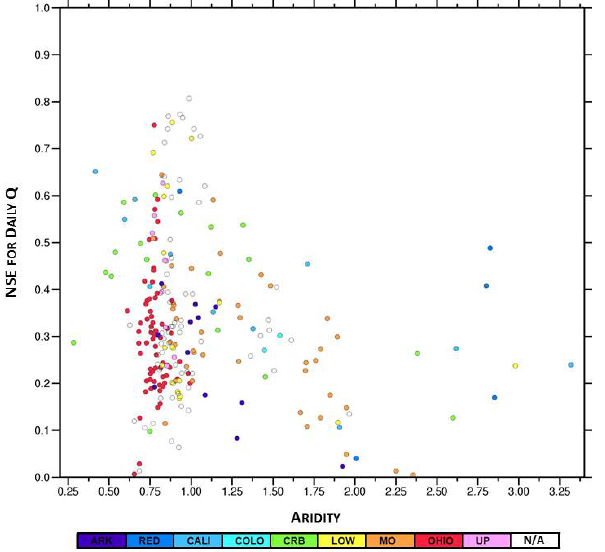
Fig. 10. NSE values for ULM calibrations towards ET SAT at a daily time step as a function of AI for the period 2001–2010. Shading of individual points denotes the major region for each